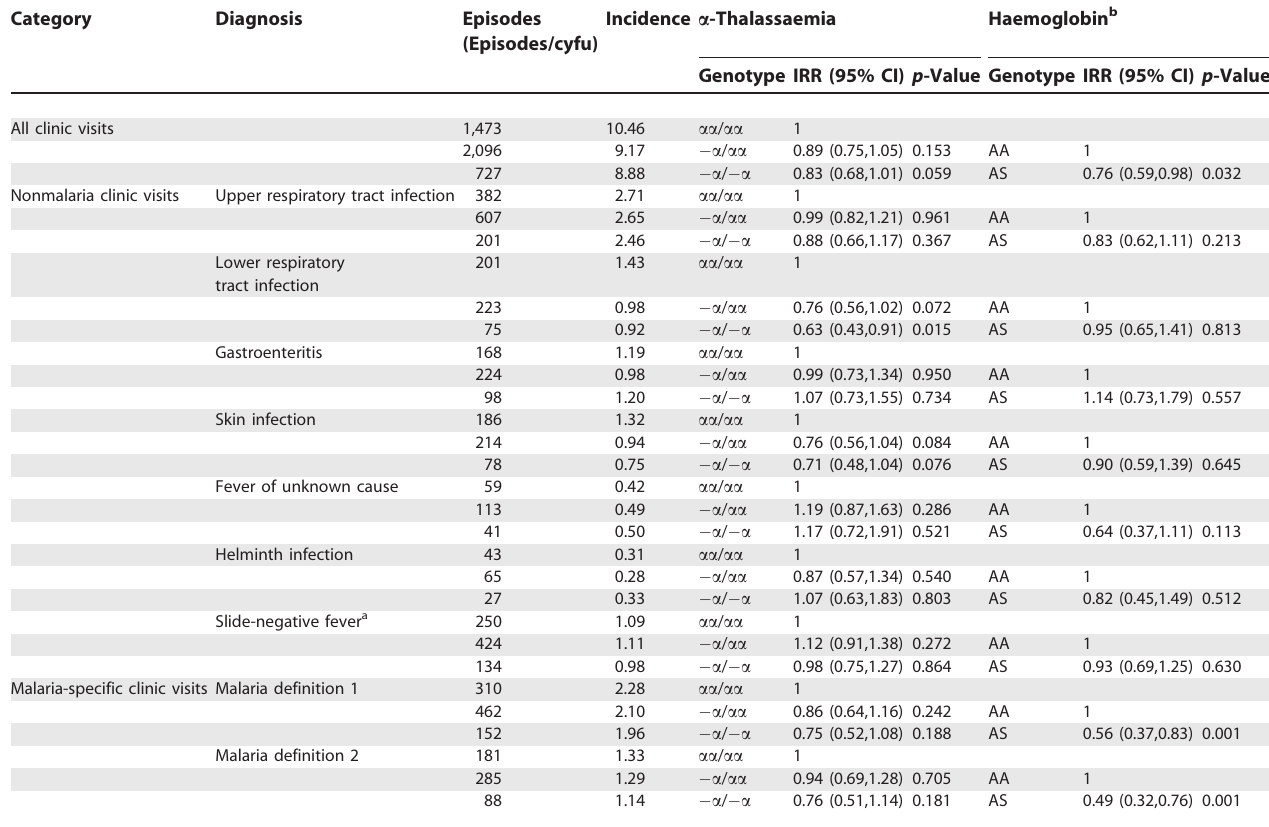
Table 1. The Incidence of Mild Clinical Malaria and Other Diseases by a þ -Thalassaemia Genotype Category Diagnosis Episodes Incidence a (Episodes/cyfu)